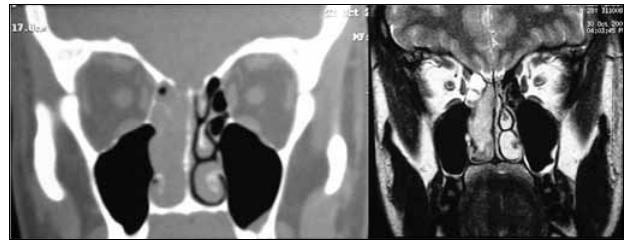
Figure 2. Preoperative CT and MRI of the patient JPP; stage Kadish D and Dulguerov T2n1. Source: own